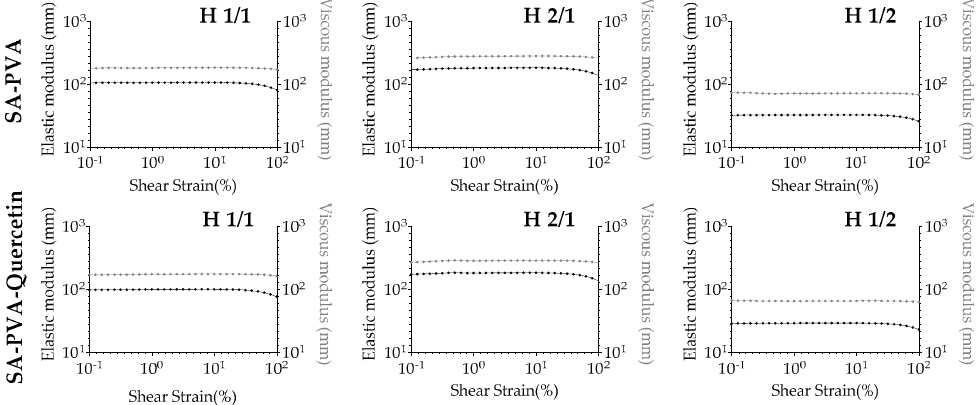
Figure 5. Resistance to deformation from determination of viscoelastic region of unloaded (top row) and quercetin-loaded (bottom row) SA-PVA hydrogels.